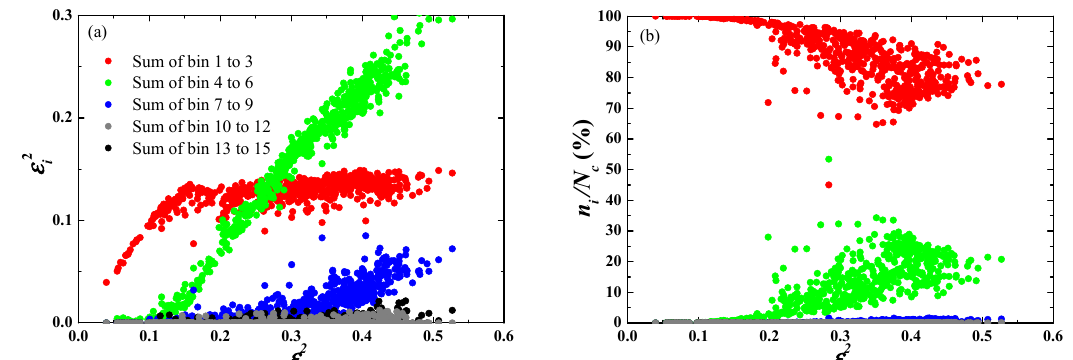
Figure 8. Contribution values to ε 2 ( ε 2 ) and number concentration ratios ( n i / N ) of different size ranges of droplets at different ε 2 , corresponding to Figure 8( a ) and ( b ), respectively.